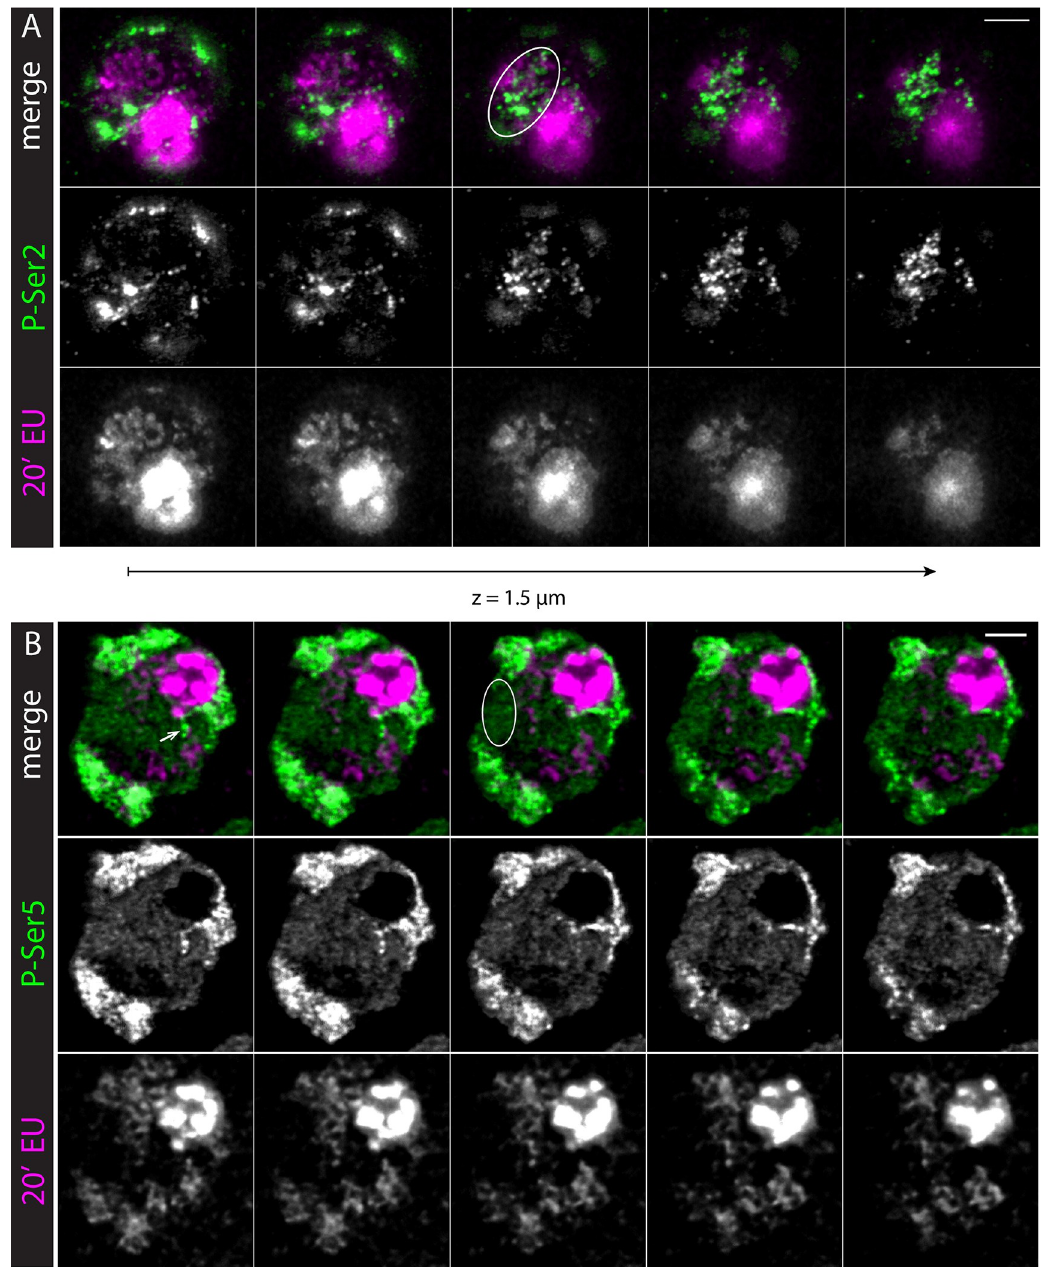
Fig 11. Differential association of nascent RNA with RPol-PSer2 and RPol-PSer5. Primary spermatocytes in larval testes stained for EU to label nascent RNA (bottom rows, magenta in merge) after a 20min incubation period and by immunolabelling for RPol-PSer2 (A) or RPol-PSer5 (B) (middle rows, green in merge). Consecutive confocal sections are shown from left to right covering approx. 1.5 μ m along the z-axis. Scale bars, 3 μ m. Nascent RNA accumulates around RPol-PSer2 along Y loops (ellipse in A), while RPol-PSer5 is frequently found without associated nascent RNA in the nucleoplasm (ellipse in B). Arrow in B points to prominent Y loop structure at the nucleolus, which is enriched with RPol-PSer5. Additionally, nascent RNA is enriched in chromosome masses in the nuclear periphery, which contain RPol with both CTD modifications, and in the nucleolus, where transcription is mostly performed by RPol1 (saturated round structure). Due to the high range of intensities some structures are saturated to visualize signals along the less dense Y